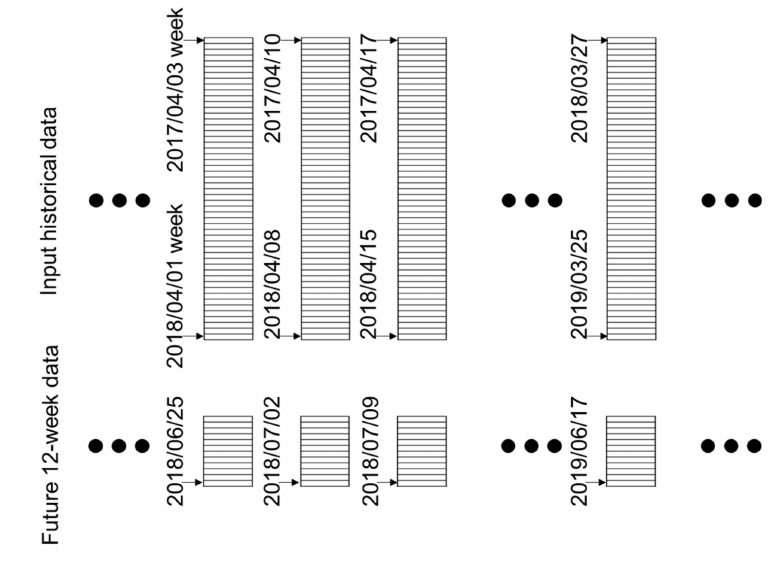
Figure 4. The 52 samples extracted from one stock